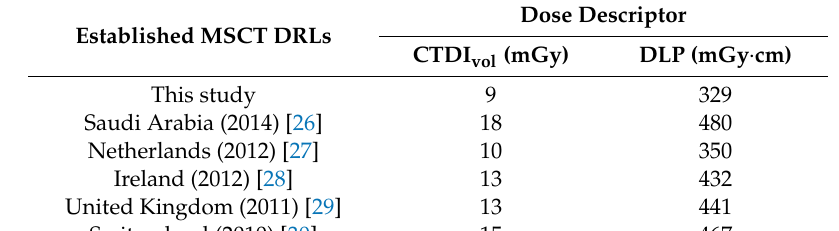
Table 6. Comparison of DRLs in CTPA with other studies.